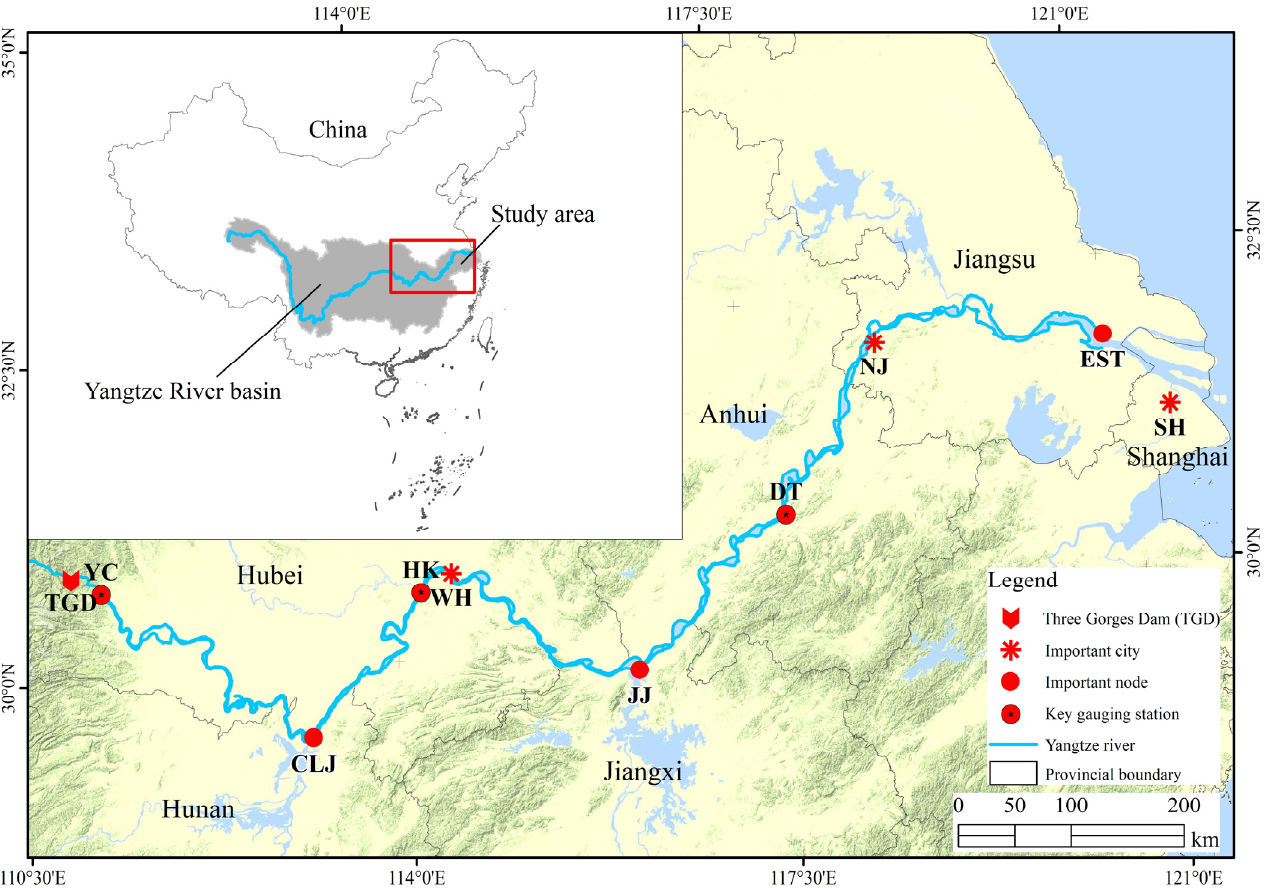
Figure 1. Geographic location of the study area. TGD, YC, CLJ, HK, WH, JJ, DT, NJ, EST, and SH stand for Three Gorges Dam, Yichang, Chenglingji, Hankou, Wuhan, Jiujiang, Datong, Nanjing, Yangtze River Estuary, and Shanghai, respec- tively.